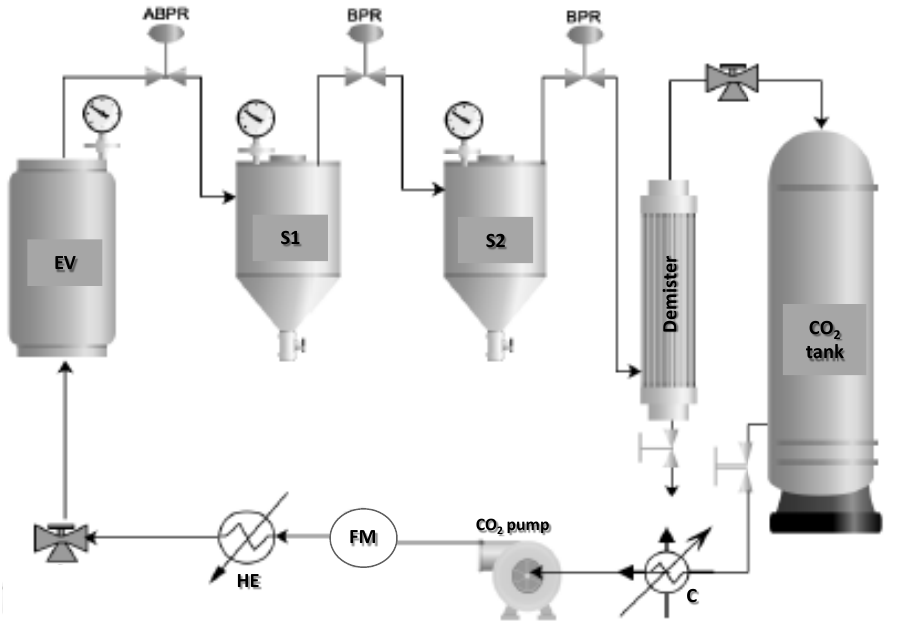
Figure 1. Schematic diagram of the SFE plant: EV, extraction vessel; S1, first separator; S2, second separator; ABPR, automatic back pressure regulator; BPR, back pressure regulator; C, CO 2 cooler; FM, flow meter; HE, heat exchanger.